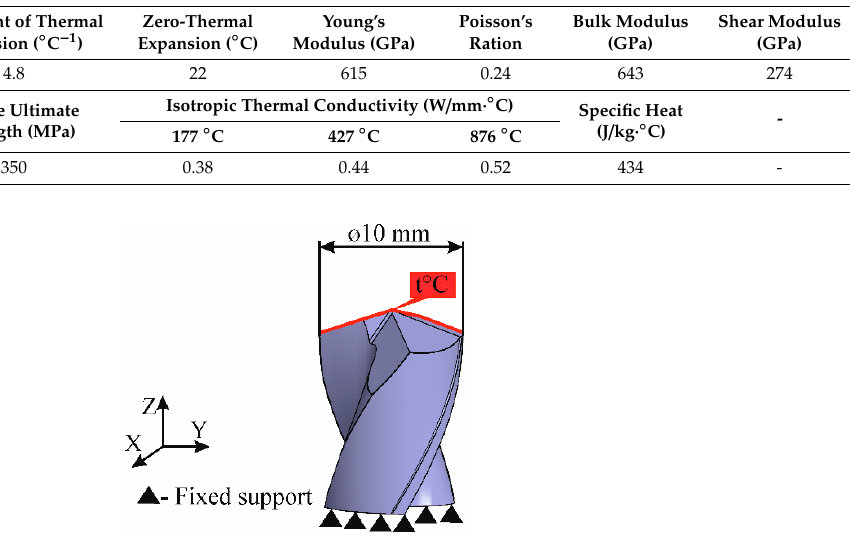
Figure 1. Schematic illustration of the FE model of a drill.